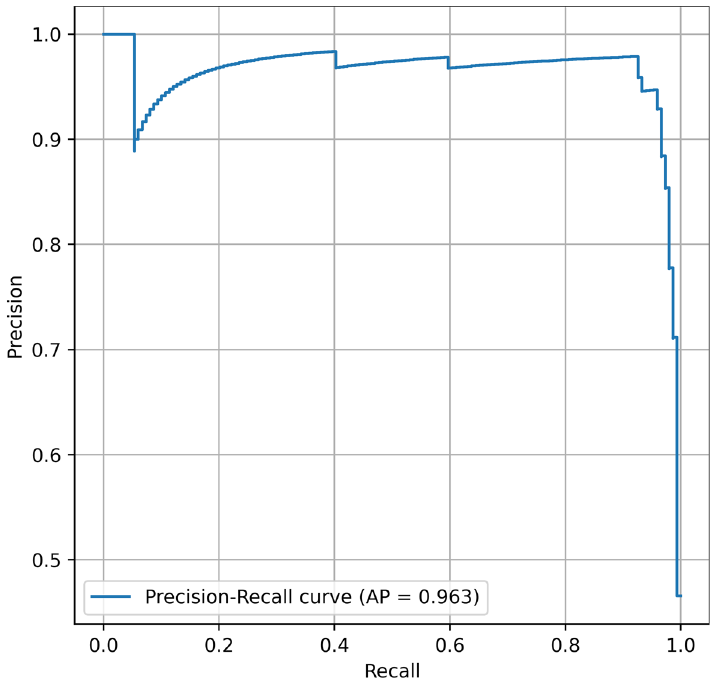
Figure 3. Precision-Recall-curve.